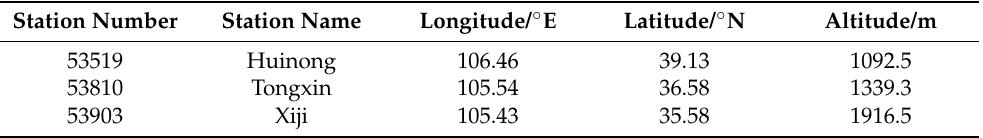
Table 1. Information about meteorological stations in the sample.